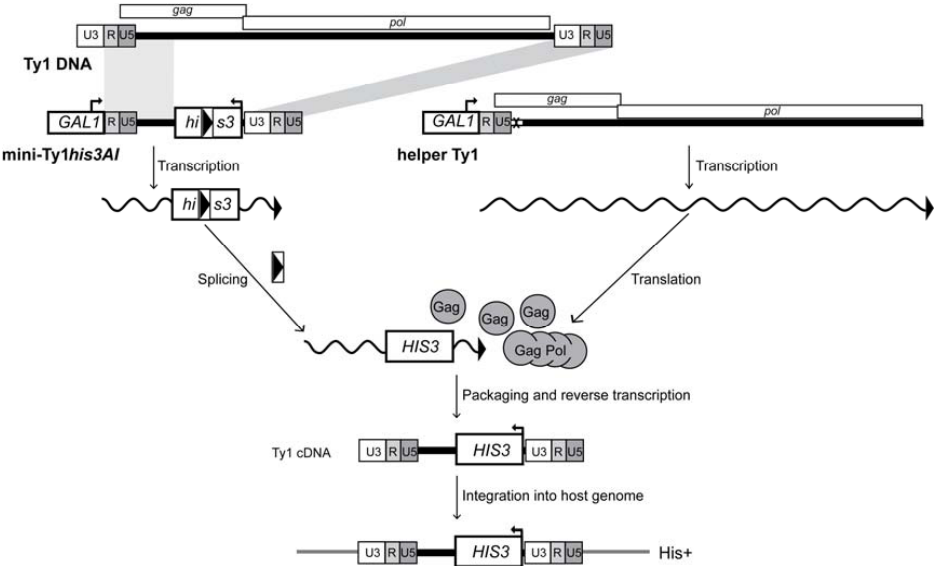
Figure 5. Assay for helper ‐ mediated retrotransposition of mini ‐ Ty1 his3AI . A complete Ty1 element is shown at the top for reference. The mini ‐ Ty1 his3AI element and helper ‐ Ty1 element are each expressed from the GAL1 promoter (labeled rectangle), which is fused to the transcription start site of Ty1 ‐ H3 at the first nucleotide of the R domain in the 5 ′ LTR. GAL1 :mini ‐ Ty1 his3AI is carried on a URA3 ‐ based plasmid and GAL1 :helper ‐ Ty1 is contained on a TRP1 ‐ based plasmid (not illustrated). The elements are co ‐ expressed in an spt3 ∆ strain lacking endogenous Ty1 element transcription. The